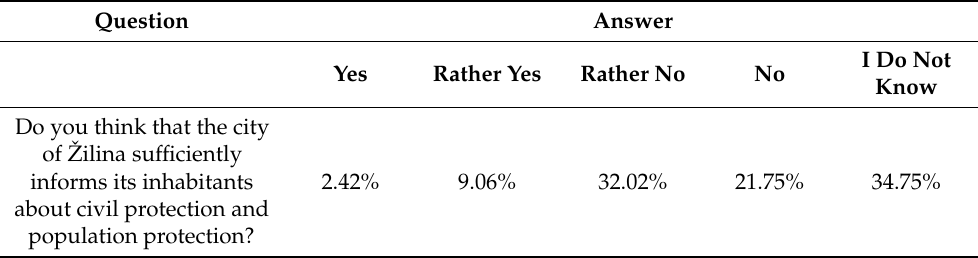
Table 7. Respondents’ sense of awareness of the city of Žilina in the field of civil protection and population